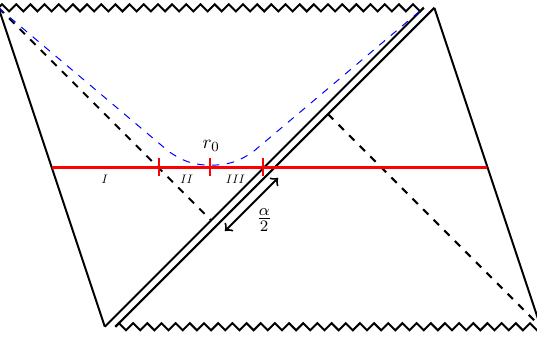
Figure 6 . Extremal surface (horizontal, red) in the shock wave geometry. We split the left half of the surface into three parts, I , II and III . The segments II and III have the same area and they are separated by the point r 0 at which the constant- r surface (blue, dashed curve, de(cid:12)ned by r = r 0 ) intersects the extremal